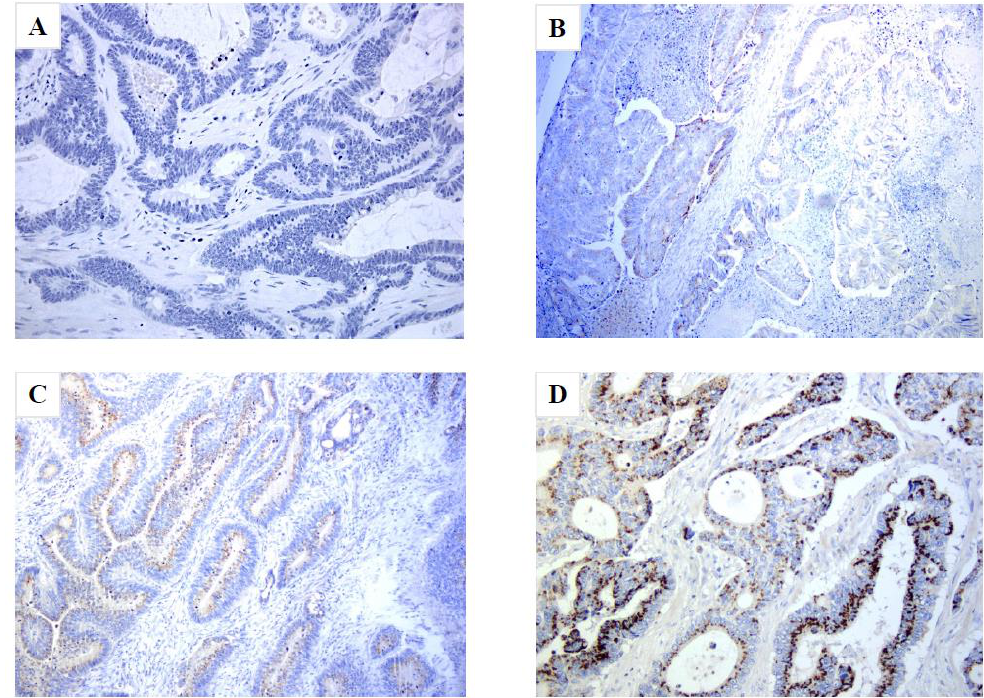
Figure 1. p65BTK expression in specimen samples of stage III CRC. p65BTK Hematoxylin and Eosin (H&E) staining, original magnification 200 × . ( A ) Tumor sample with 0% p65BTK expression. ( B , C ) Tumor samples with an intermediate percentage of expression. ( D ) Tumor sample with 100% p65BTK expression.